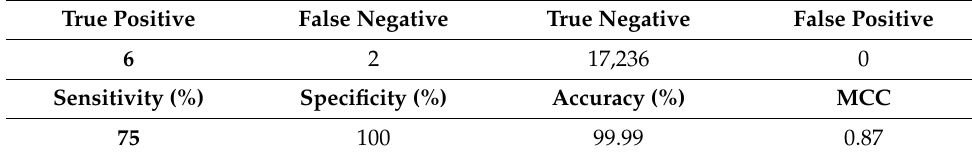
Table 2. Independent testing of the profile.